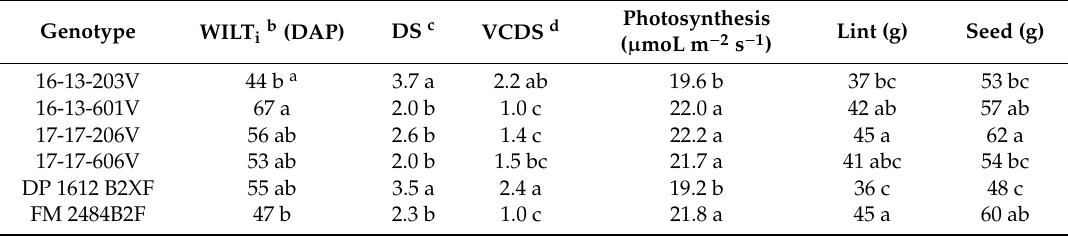
Table 1. Least square means for initial Verticillium wilt development (WILT i ), disease severity (DS), vascular cross-section severity disease rate (VCDS), photosynthesis rate, lint yield per plant (Lint) and seed yield per plant